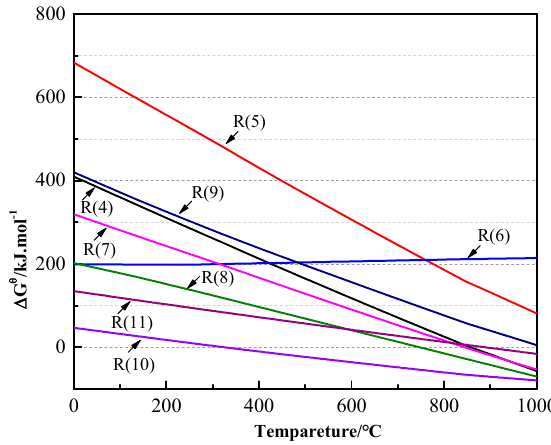
Figure 4. ∆ G T θ -T graph of reactions Figure 4. Δ G T θ -T graph of reactions (4)–(11).